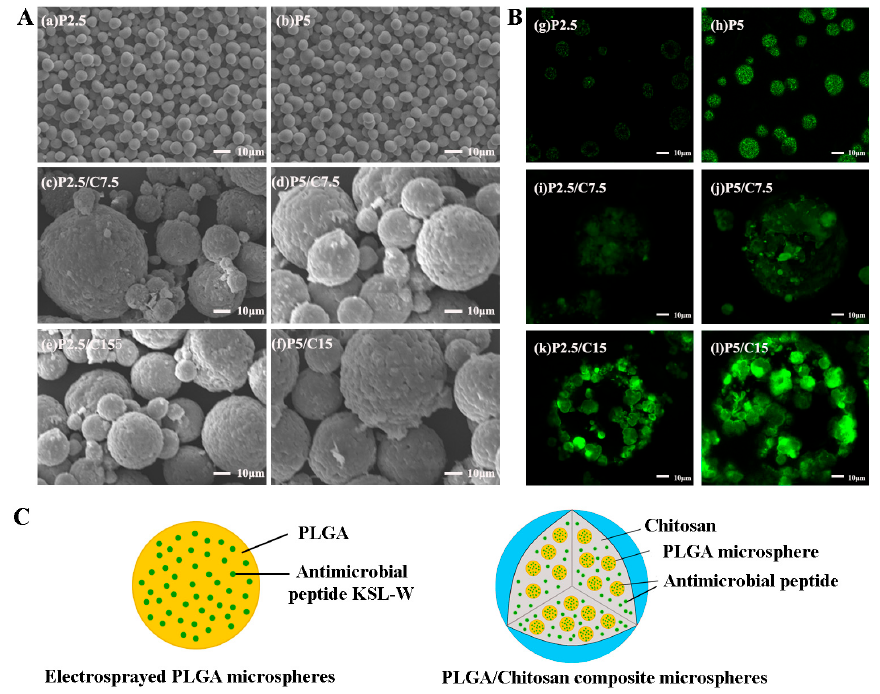
Figure 1. ( A ) The typical scanning electron microscope (SEM) morphologies of KSL-W-loaded PLGA and PLGA/CS composite microspheres; ( B ) Visualized distributions of FITC-conjugated KSL-W in PLGA and PLGA/CS microspheres under laser scanning confocal microscope (LSCM); ( C ) A schematic diagram of a KSL-loaded PLGA microsphere and a KSL-loaded PLGA/CS microsphere. PLGA, poly(lactide-co-glycolide); CS, Chitosan; FITC, fluorescein